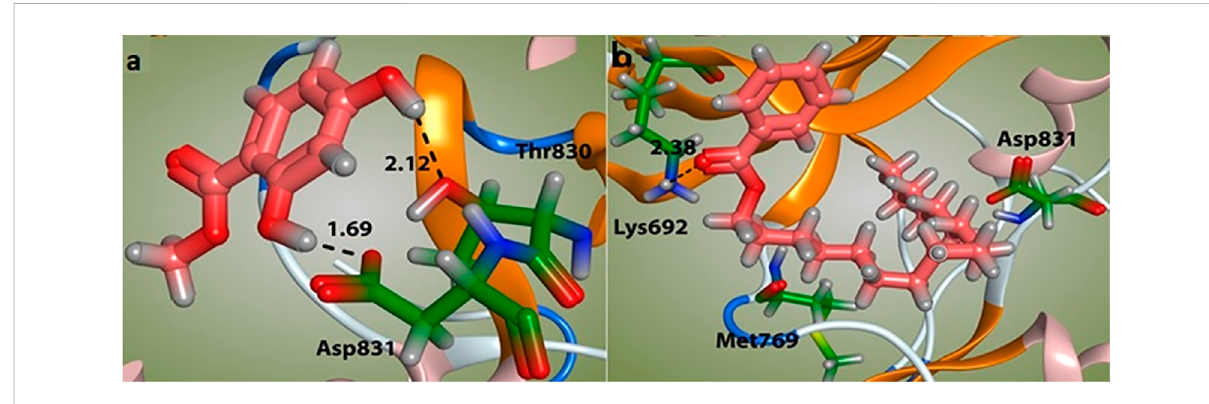
FIGURE 3 Binding mode of compounds methyl dihydroxybenzoate (A) and heptadecyl benzoate (B) with the target enzyme, (EGFR) tyrosine kinase. The ligands are shown as pink and residues as green.